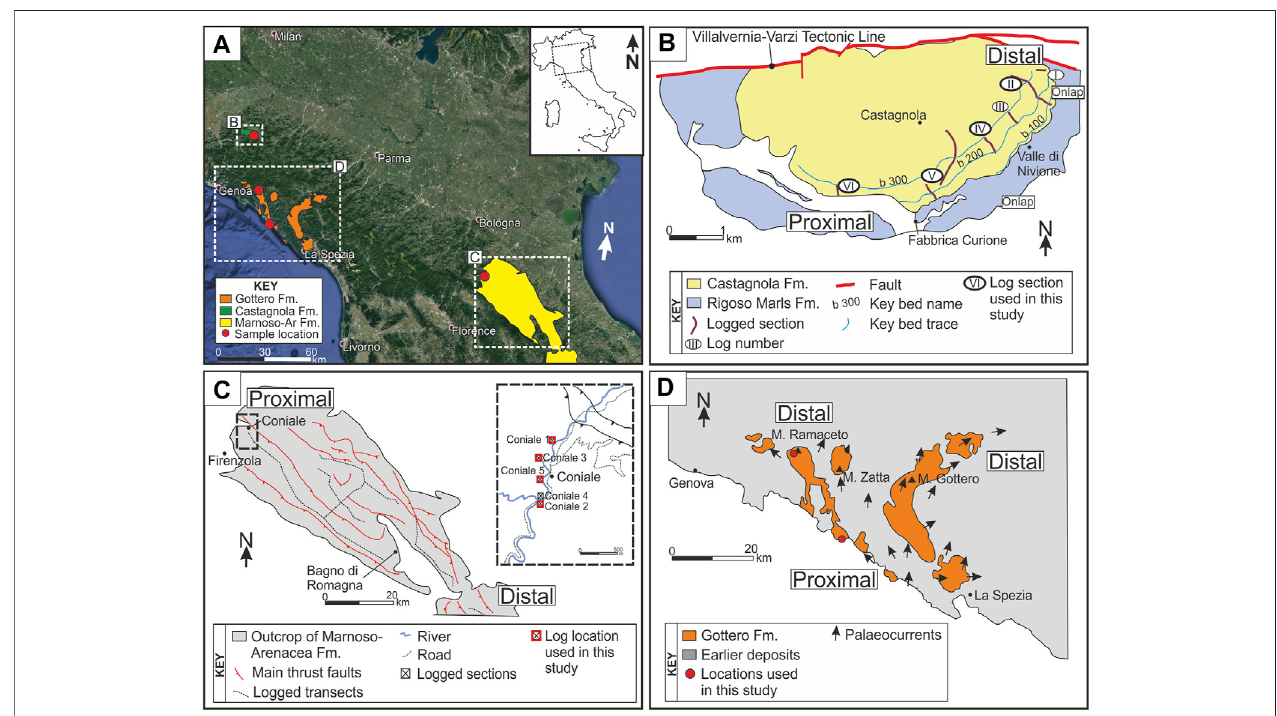
FIGURE 1 | (A) Locations of three basins in Northern Italy, the Castagnola Formation, the Marnoso-Arenacea Formation and the Gottero Formation, inset map of Italy inthetoprightcorner. (B) OutlineoftheCastagnolaFormationoutcrops(deepwater sandstoneand mudstone succession)stratigraphicallyabovetheRigoso Marls Formation, South of the Villalvernia — Varzi tectonic line (modi fi ed from Patacci et al., 2020). (C) Outline of outcrops of the Marnoso-Arenacea Formation in the Northern subbasin of the Marnoso-Arenacea foredeep, with the location of the main thrust faults through the section and logged tracts from Amy and Talling (2006). Inset map of key proximal locations in the village of Coniale (modi fi ed from Amy and Talling, 2006). (D) Location of Gottero Formation outcrops with proximal locations on the coast and distal location at Mount Ramaceto, modi fi ed from Fonnesu et al., 2018.